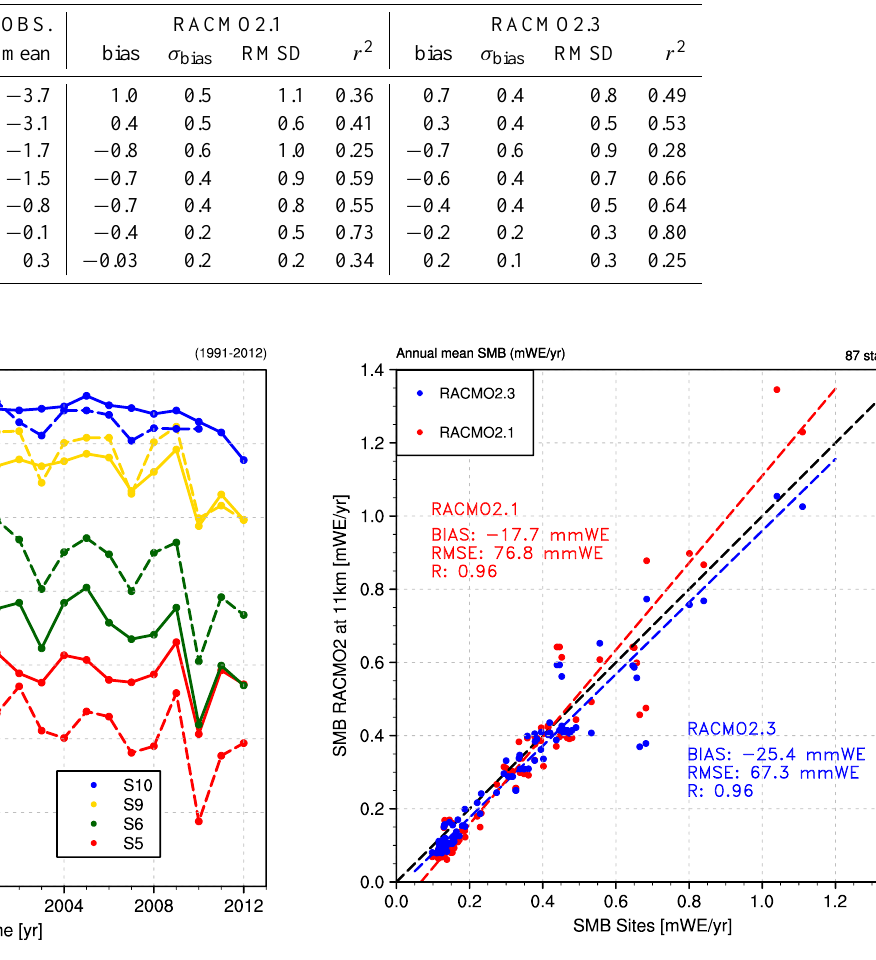
Figure 8. Observed and simulated SMB (mWEyr − 1 ) across the accumulation zone of the GrIS averaged for the period 1979–2012. The regression lines are displayed as dashed lines for RACMO2.3 (blue) and 2.1 (red). For observation locations, see yellow dots in Fig. 1.